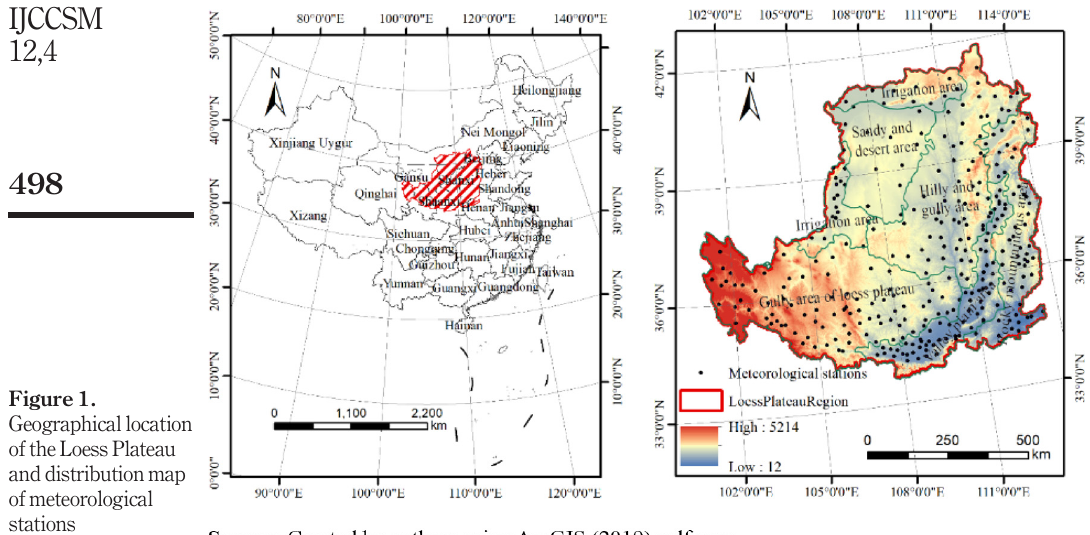
Figure 1. Geographical location of the Loess Plateau and distribution map of meteorological